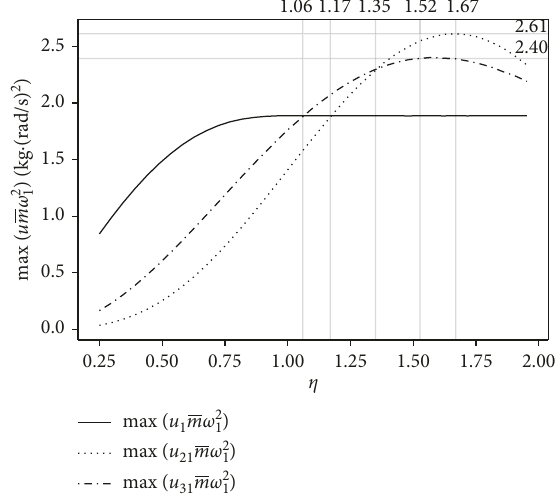
Figure 5: The maximum displacement curves of the beam under three kinds of moving load conditions with different length ratios η ( n 1; α 0 . 6; β m 0; η is from 0.25 to (cid:30) (cid:30) (cid:30)